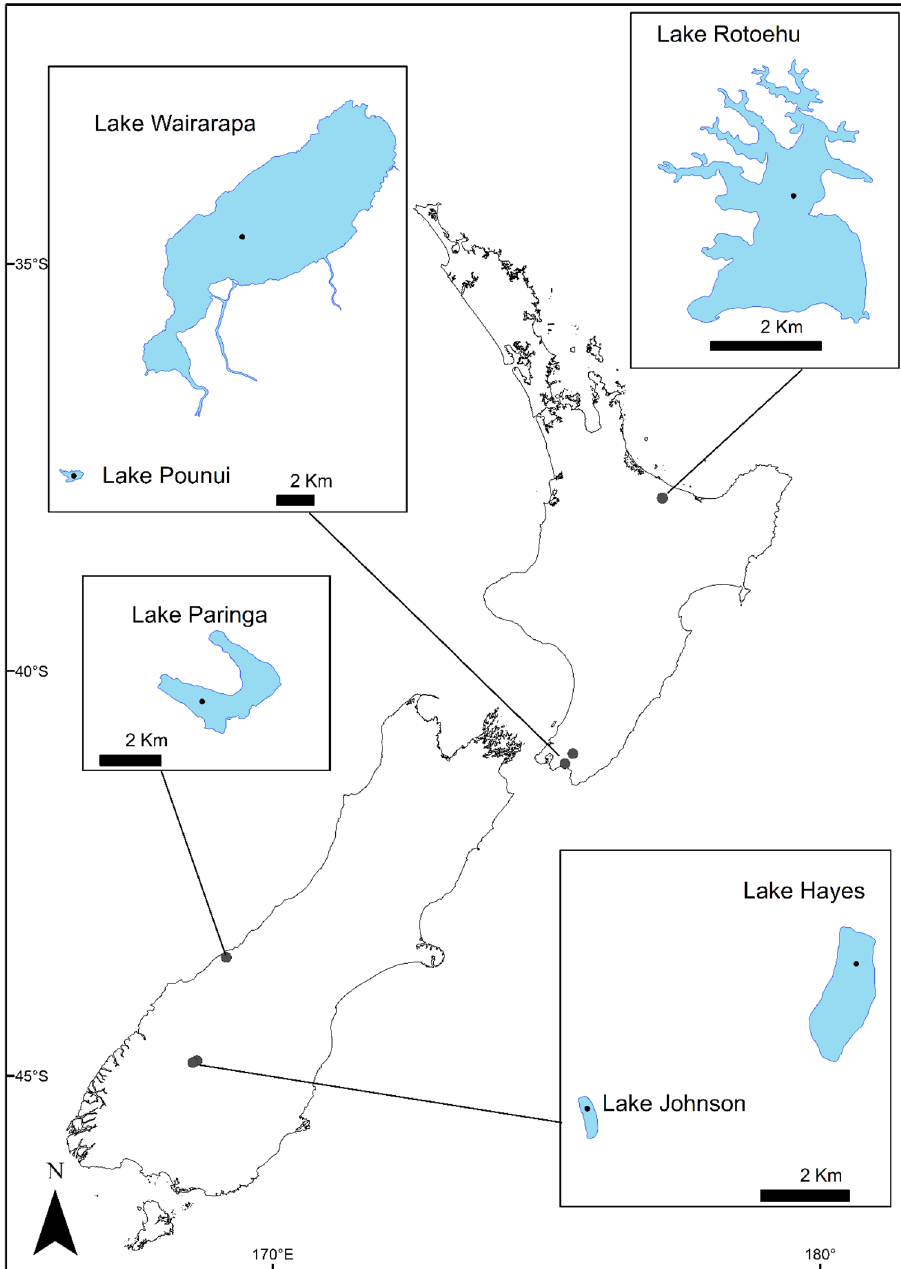
Figure 1. Location of the six study lakes, situated within the North and South islands of New Zealand and spanning 7° of latitudinal gradient. Black dots in each lake indicate coring sites. Map created using ArcGIS version 2.8 (https:// www. esri. com) by Kati Doehring, Cawthron